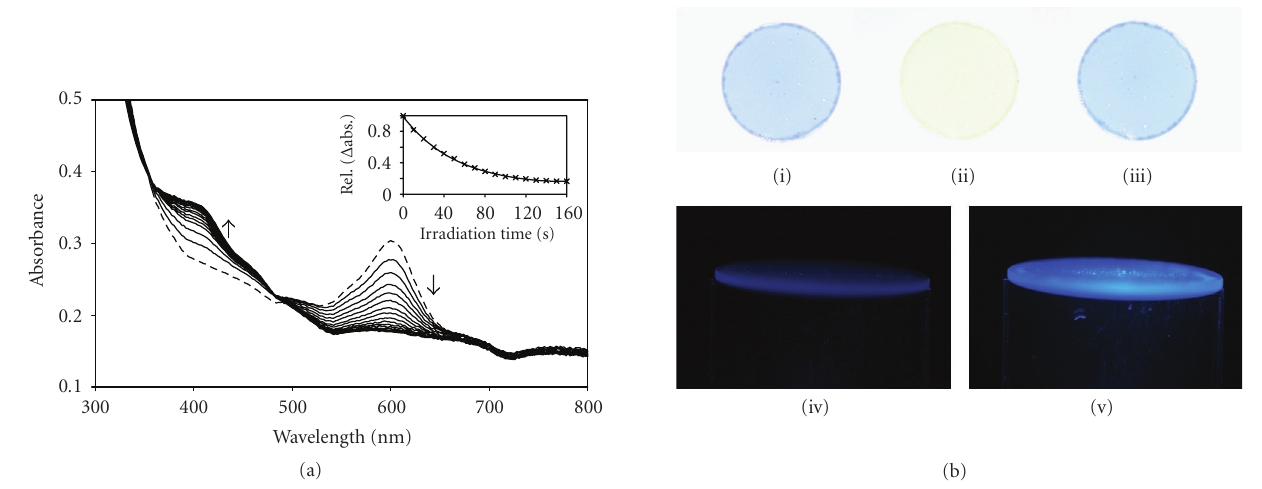
Figure 3: (a) Recorded change in the UV/Vis spectrum of an ITS oxygen indicator film (broken line), in the absence of oxygen, upon exposure to UVA light (intensity: 4mWcm − 2 ) as a function of time. The spectra illustrated were irradiated (from top to bottom at 600 nm) for 0 second up to 160 seconds, in 10-second intervals. The insert diagram illustrates the change in absorbance of the indicator film at 600nm as a function of irradiation time, derived from the data in the main diagram. (b) Photographs of an oxygen indicator film on a coverslip. (i) TO 2 /ITS/glycerol/HEC film before and (ii) after 30 seconds UVA irradiation (I = 7mWcm − 2 ), and (iii) film in photograph (ii) allowed to recover after 15 minutes in air. (iv) Photograph of film (i) under very low UV-light illumination in the presence of oxygen. (v) Photograph of film (ii) also under very low UV-light illumination.